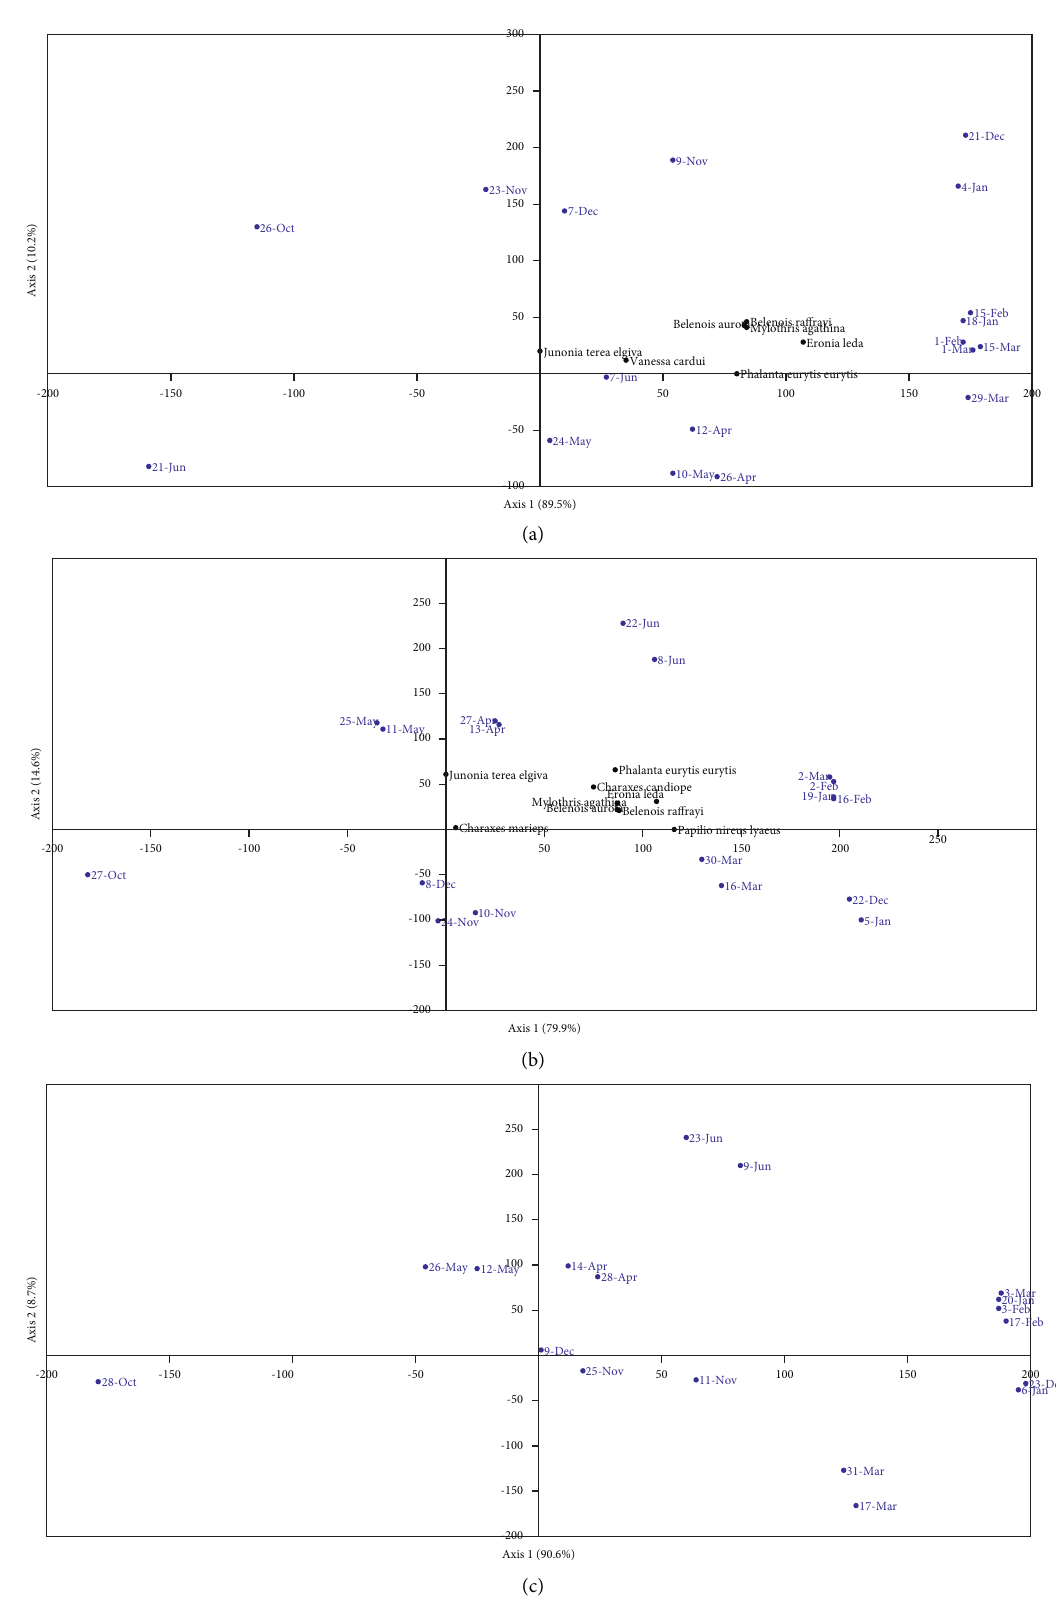
Figure 7: Ordination of butterfly species and sampling date by detrended correspondence analysis at three locations in Tana Basin (northwestern Ethiopia). (a) Mount Bezawit. (b) Alemsaga. (c) Tara